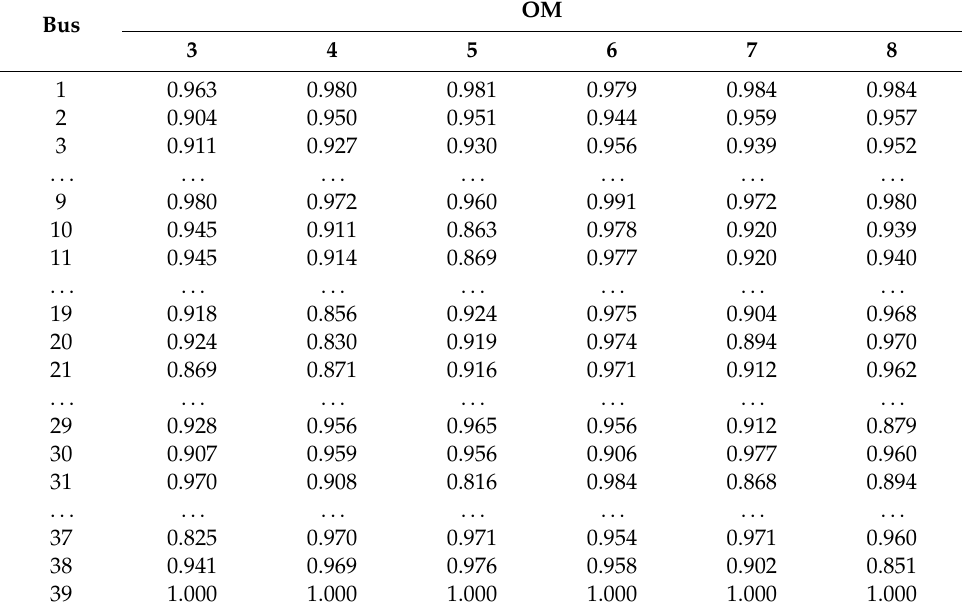
Table 2. Mean value of controllability indices of buses to di ff erent oscillatory modes (OMs).